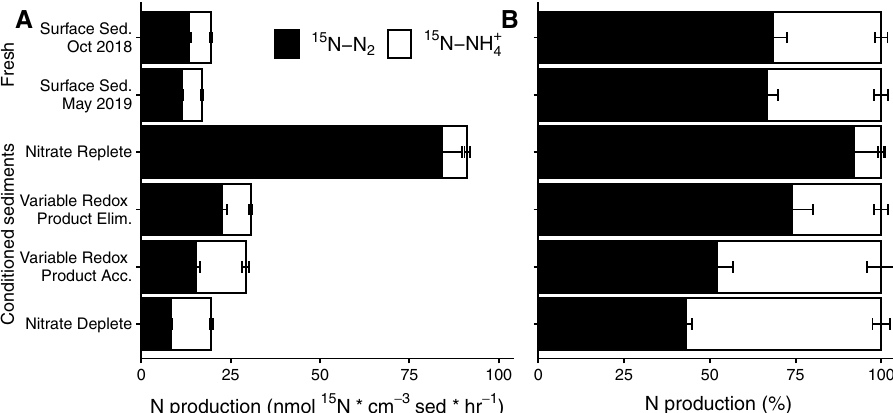
Fig. 4 NO 3- reduction: A Rates of N 2 (black) and NH 4 + production (white) in nmol 15 N cm − 3 sed. in the four conditioned sediments and two freshly collected surface sediments. All error bars represent standard error of rates. All rates were fi t to points where N 2 production was approximately linear, and all rates have an R 2 of at least 0.86 (see Supplementary Tables 1, 2 for associated statistic). B Normalized data from panel A showing the 15 N-NO 3- converted to NH 4 + or N 2 as a percentage of the total rate of 15 N-NO 3- conversion to either N 2 or NH 4 + . Error bars represent propagated standard error. The conditioned sediment incubations were carried out in October